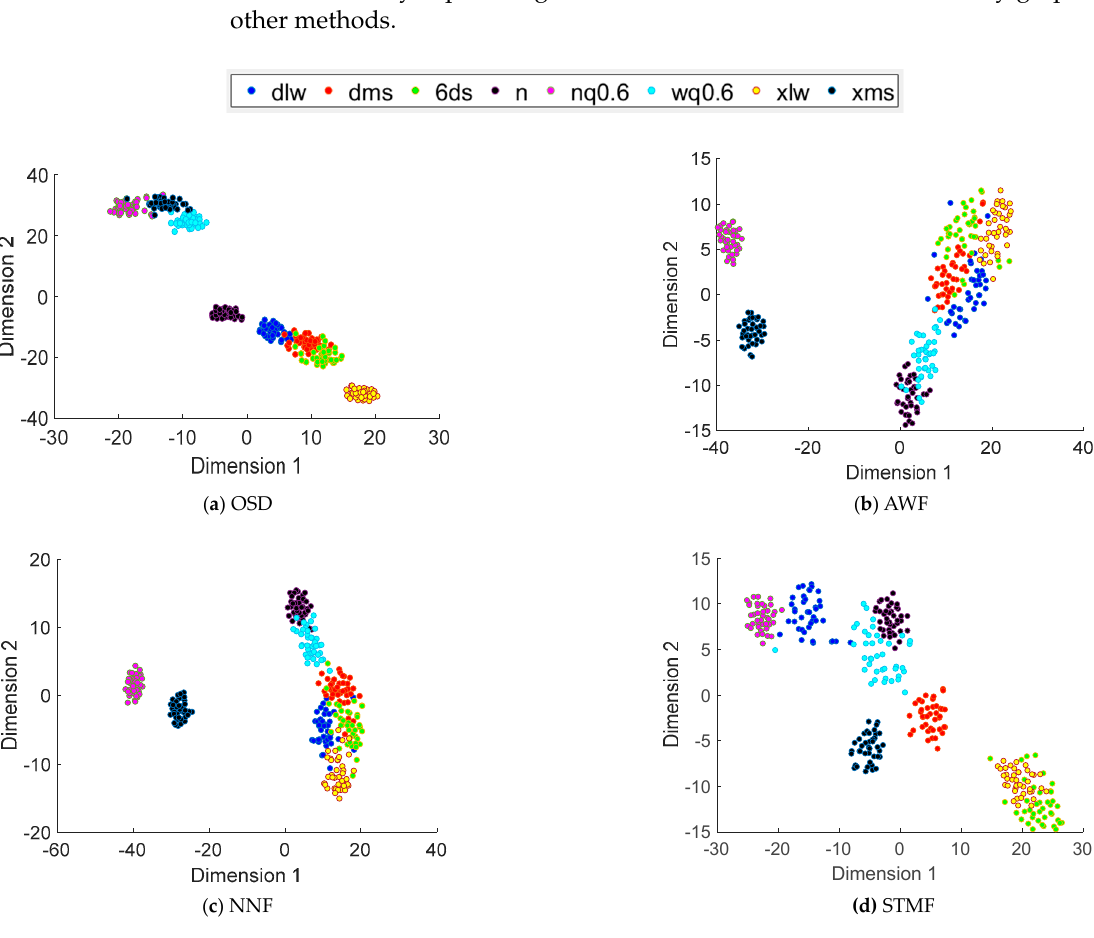
Figure 13. Comparison of eight types of fault classification results under 1300 rpm.